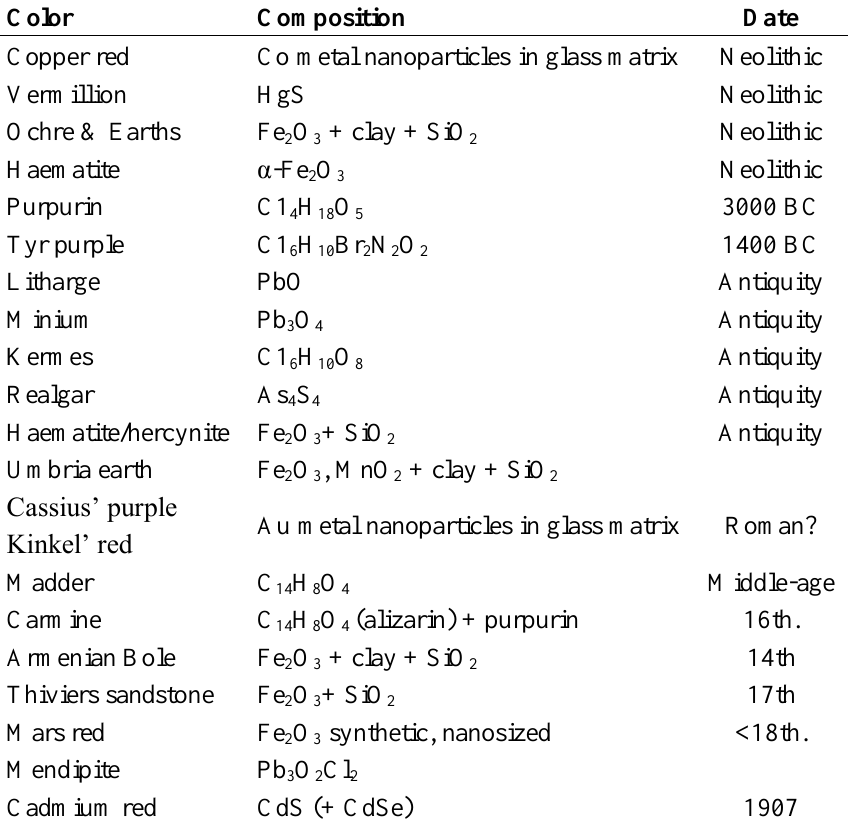
Table 5. Name and composition of red pigments and coloring agents. Dates of innovation (first production) are